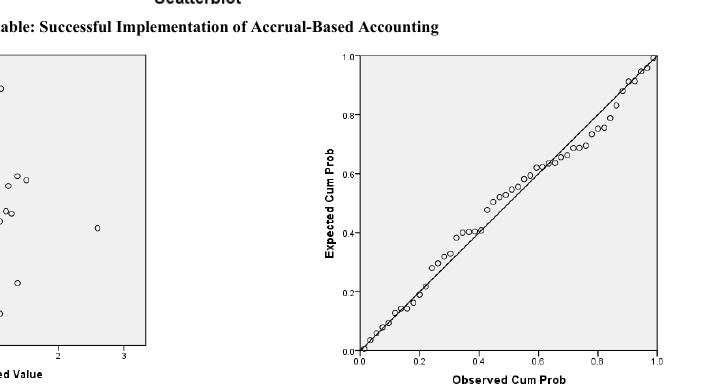
Fig. 2. Heteroscedasticity Test Results – Scatterplot Graph